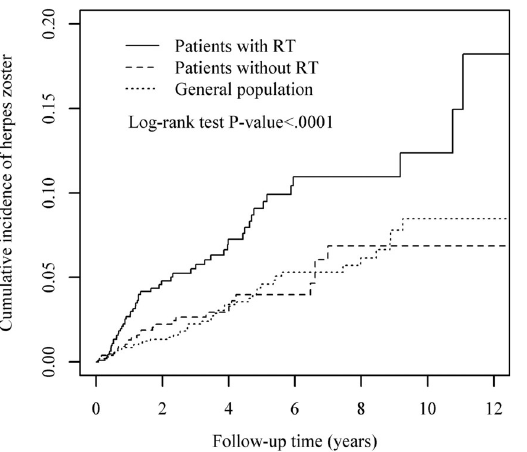
Fig 1. Cumulative incidence rates of herpes zoster in the radiotherapy cohort, non-radiotherapy cohort, and general population. RT, radiotherapy.